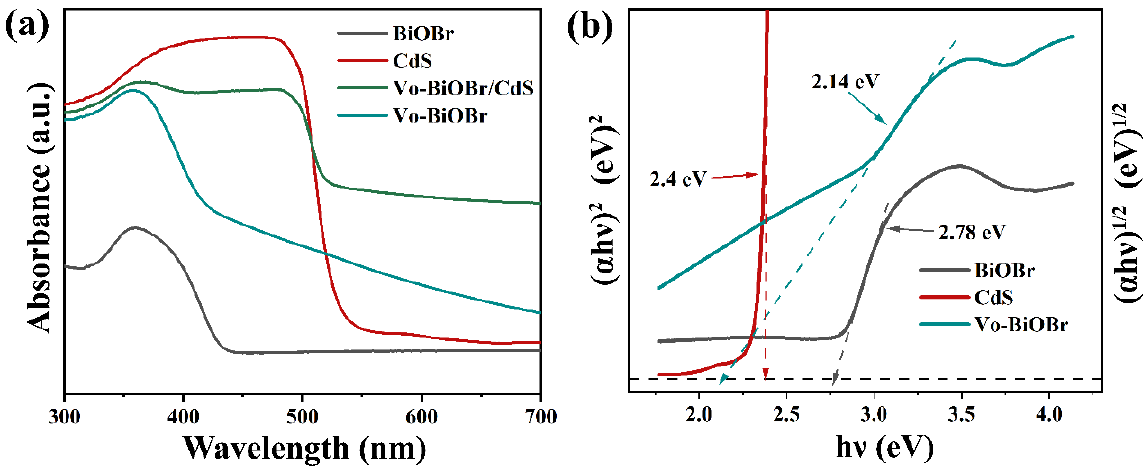
Figure 5. ( a ) UV-vis DRS, and ( b ) Tauc plots of BiOBr, Vo-BiOBr, CdS and Vo-BiOBr/CdS.